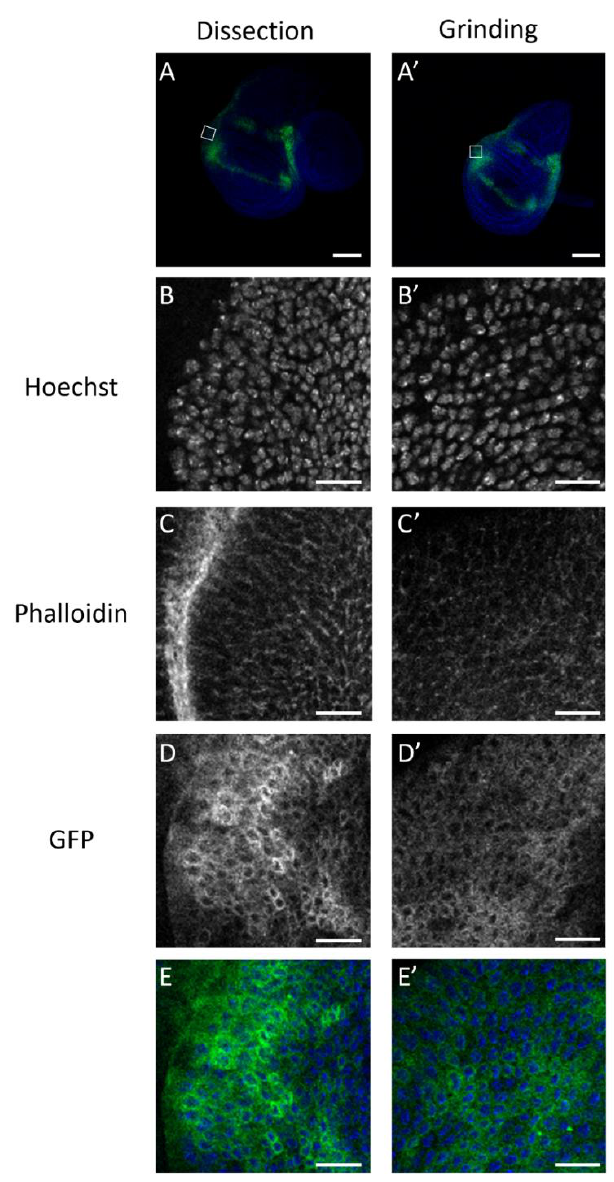
Figure 5. Cell structure in wing imaginal discs recovered by dissection or mass-enrichment protocol. Cell structure was assessed in wing imaginal discs recovered by dissection ( left column) or mass- enrichment protocol ( “ grinding ” , right column). Confocal images were acquired with 10X objective, and only a slice of this pseudocolumnar epithelium is shown ( A , A’ ). Images ( B – E’ ) correspond to the same wing imaginal discs and were acquired with a 63X objective. They show a zoomed-in view of the white boxes in ( A , A’ ). Nuclei were visualized using Hoechst ( B , B’ ), plasma membrane using phalloidin ATTO655 ( C , C’ ). GFP is coupled to mCD8 protein, whose expression is driven by the vg-GAL4 driver ( D , D’ ). Representative overlays of nuclei staining (blue) and GFP (green) are shown in whole discs ( A , A’ ) or in an enlargement of the wing imaginal disc posterior zone. Images E and E’ are an overlay of (( B , D , B’ ) and ( D’ )), respectively. Scale bars correspond to 100 µm ( A , A’ ) or 10 µm ( B – E’ ).